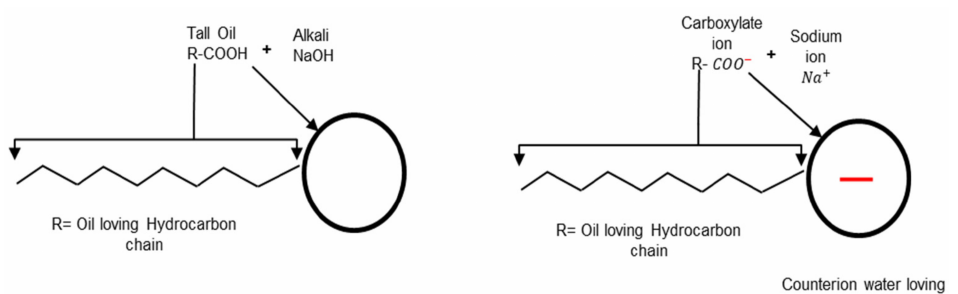
Figure 3. Example of an anionic soap production adapted from [5].